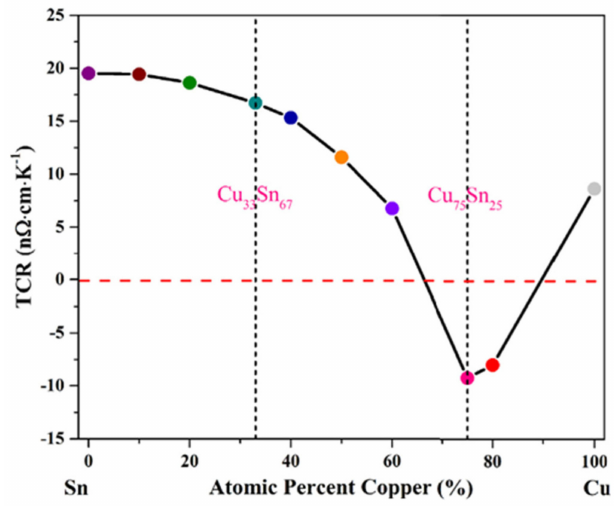
Figure 14. Composition dependence with TCR [24].